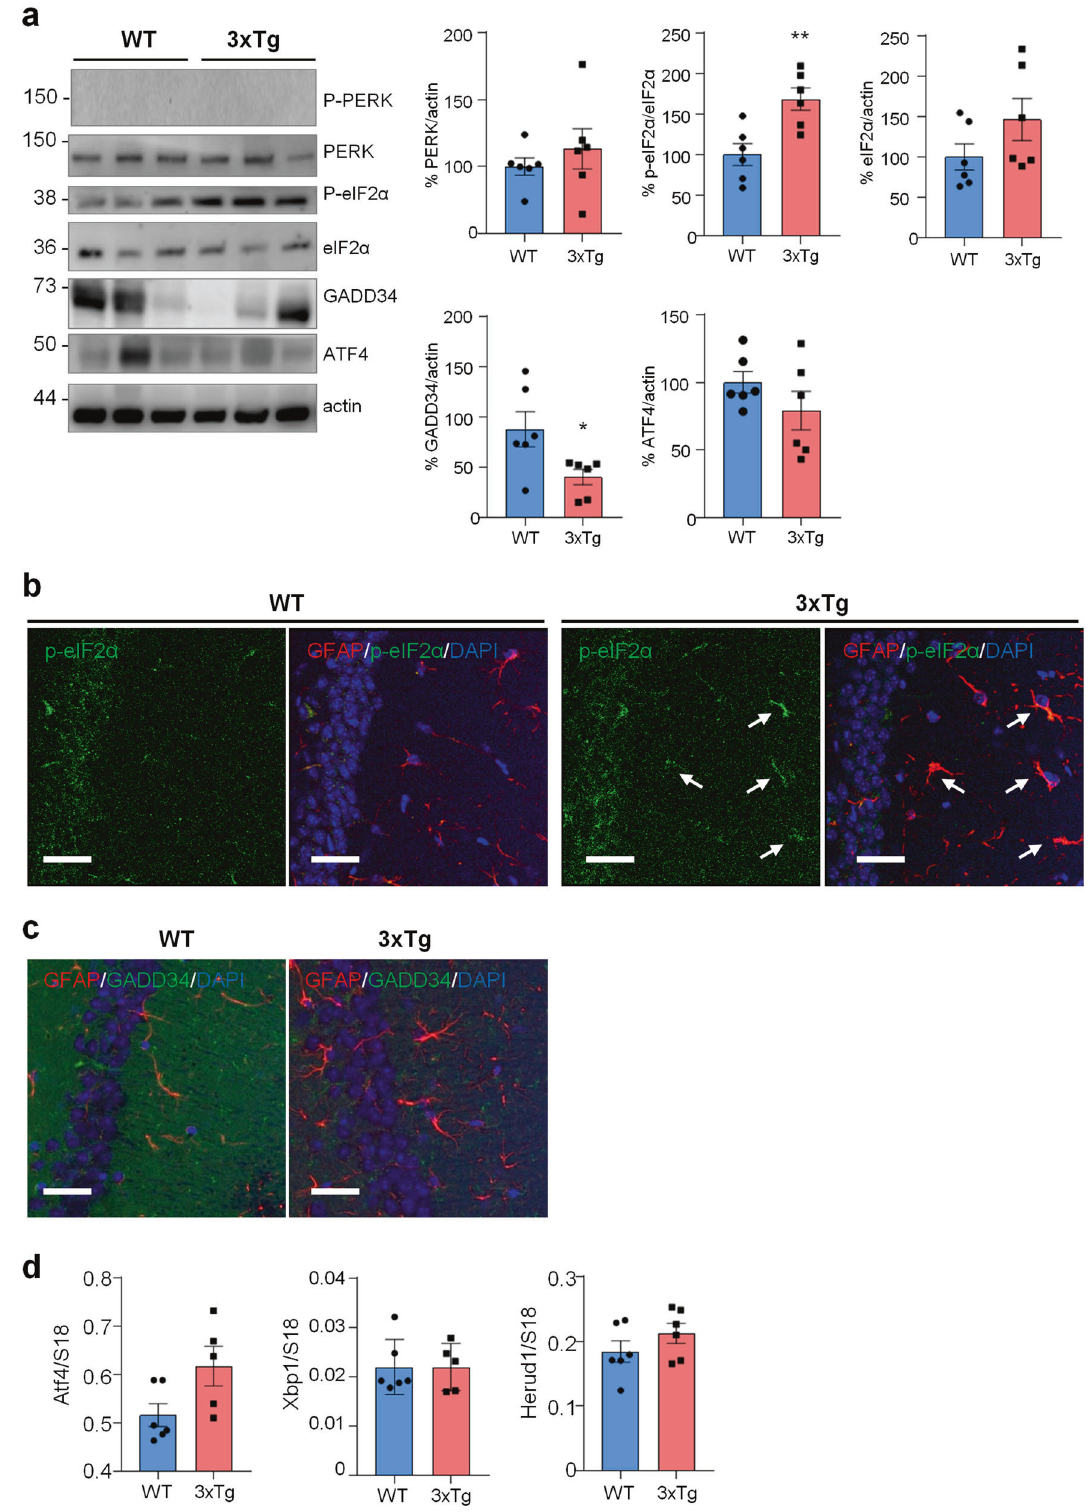
Fig. 6 ER stress/UPR pathway in WT and 3xTg-AD mice. a WB analysis with anti-PERK, p-eIF2 α , eIF2 α , GADD34, ATF4 and actin on hippocampal homogenates of WT and 3xTg-AD (3xTg) mice. Data are expressed as mean ± SEM of six independent experiments; * p < 0.05; ** p < 0.01 by unpaired t -test. b , c Co-localization of p-eIF2 α and GADD34 with GFAP and analysis on WT and 3xTg hippocampi. b IF on 40 µm thick brain slices with anti-GFAP (red), p-eIF2 α (green) and DAPI (blue). Arrows indicate p-eIF2 α -expressing GFAP-positive astrocytes. c IF on 40 µm brain slices with anti-GFAP (red) and GADD34 (green) and DAPI (blue). Images were acquire using Leica SP8 LIGHTNING Confocal Microscope imaging systems, scale bar = 25 µm. d qPCR of Atf4, Xbp1s and Herpud1 on the hippocampi of WT and 3xTg mice. Data are expressed as mean ± SEM of 5 – 6 independent experiments, unpaired t -test analysis.